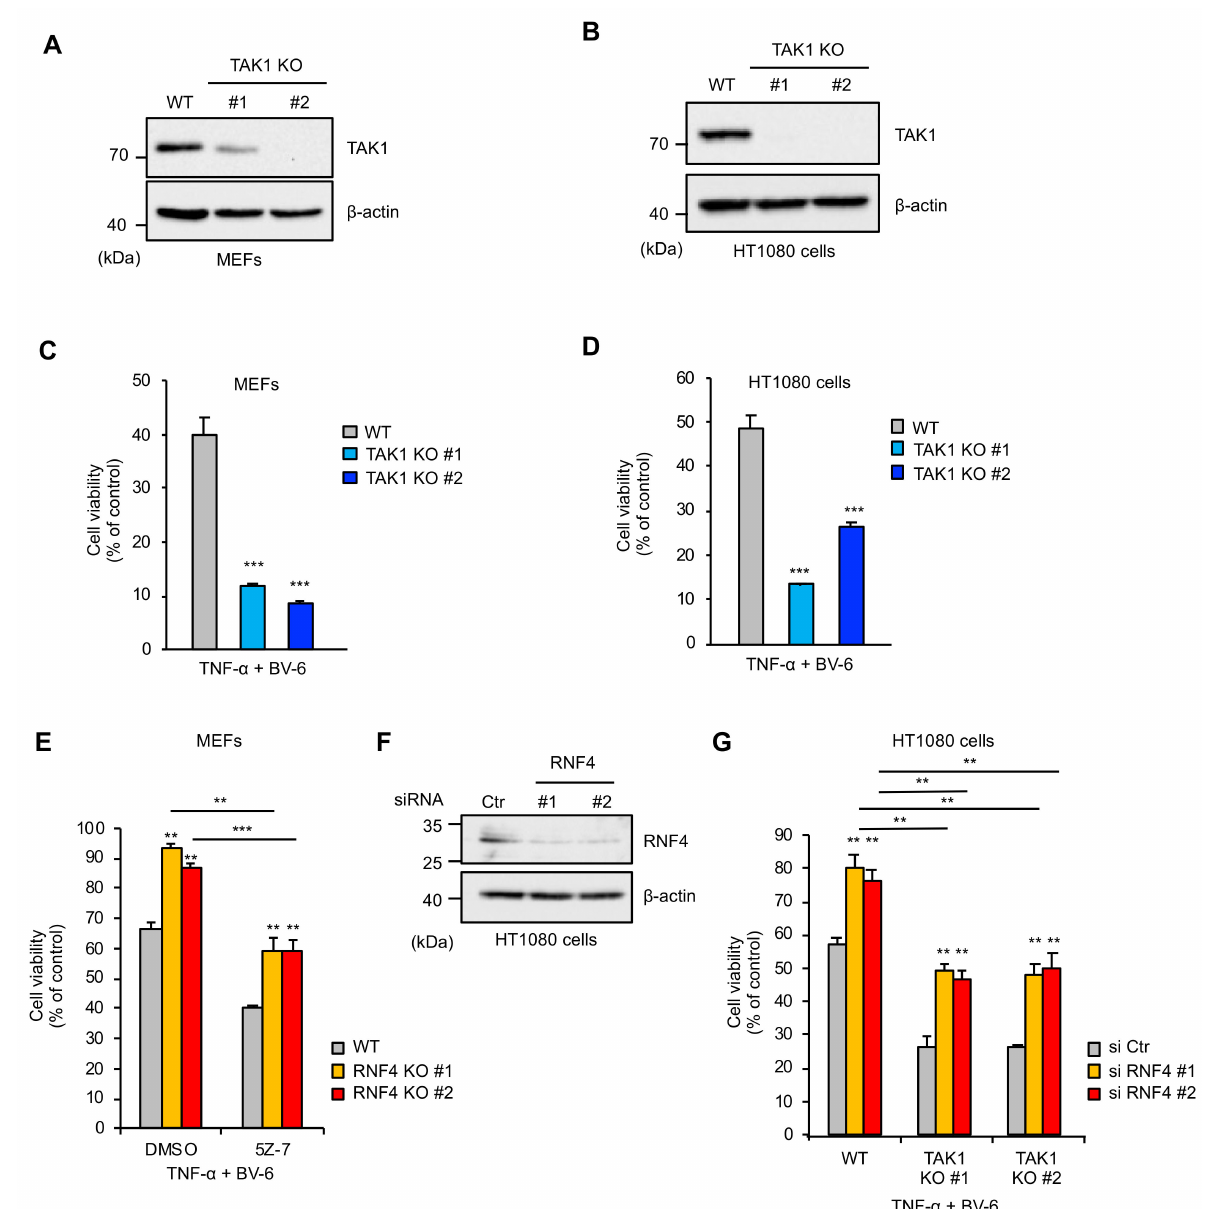
Figure 4. RNF4 promotes TNF- α -induced cell death independently of its inhibitory effects on the TAK1 signaling. ( A , B ) Im- munoblot analysis of TAK1 in MEFs (A) and HT1080 cells ( B ). Cells were subjected to immunoblotting with the indicated antibodies. β -actin was used as a loading control. ( C , D ) Effect of TAK1 deletion on TNF- α -induced cell death in